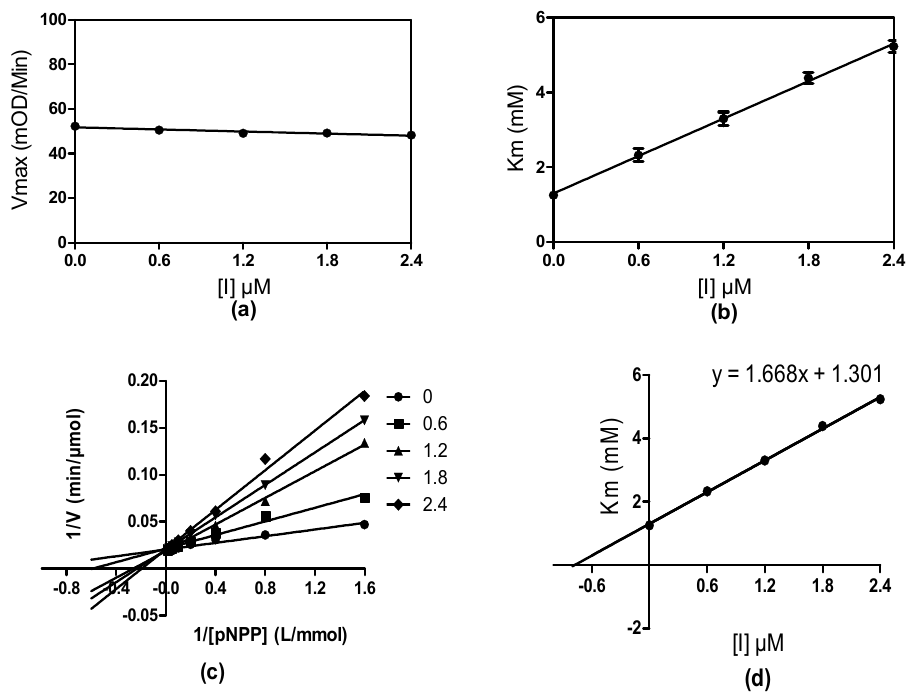
Figure 3. Characterization of 29 to PTP1B. ( a , b ) At various fixed concentrations of 29 the initial velocity was determined with various concentrations of pNPP; ( c ) Typical competitive inhibition of 29 shown by Lineweaver–Burk plot; ( d ) Linear replot of K m versus the inhibitor ( 29 ) concentration [I]. 3. Experimental